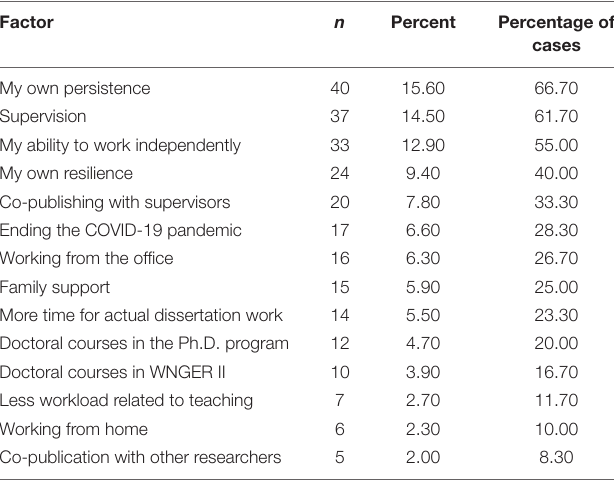
TABLE 2 | Most important factors to complete the Ph.D. project: frequency and percentage. Factor n Percent